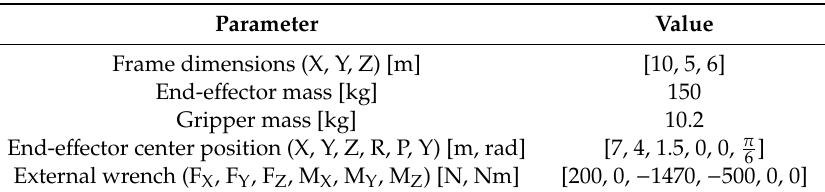
Figure 18. Dynamic model of one of the grippers. By pulling “Cable j”, the spring K A elongates and the gripper begins to close, moving towards the end-effector. This gripper moves along a linear guide, and the secondary cable moves inside the end-effector. The pulley is designed to align this cable in a vertical way. Table 4. Cable-driven robot parameters.